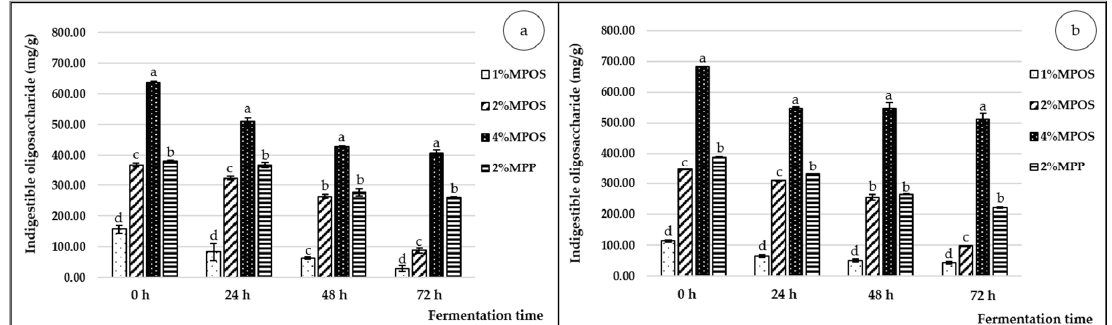
Figure 2. Indigestible oligosaccharide of L. reuteri DSM 17938 ( a ) and B. animalis TISTR 2195 ( b ) in the media supplemented with different contents of MPOS and 2% MPP (control) cultivated for 72 h of fermentation time. Different letters on the bars in the same fermentation time indicate statistically significant differences ( p < 0.05).